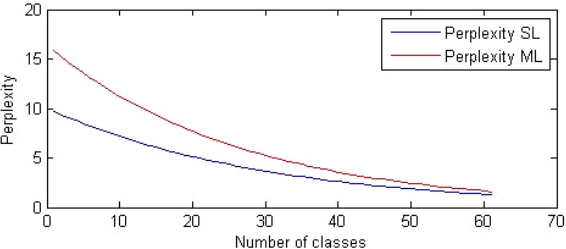
Figure 14. Perplexity curves for ERS dataset. The inflection point—27 (for Single-Look) and 26 (for Multi-Look).